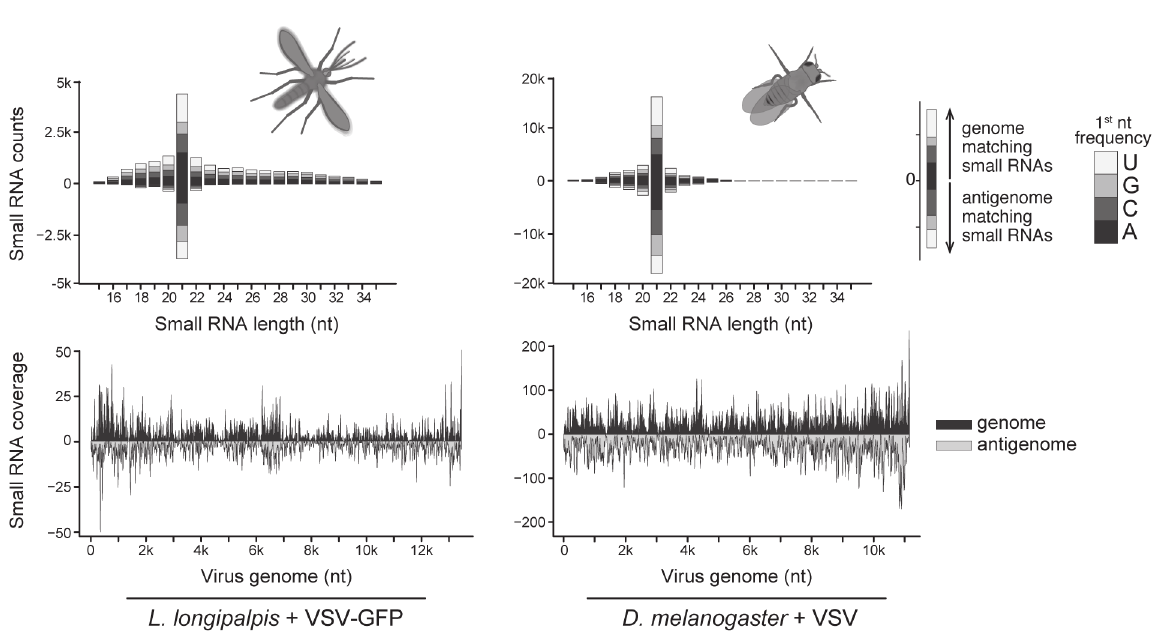
Figure 2 - Vesicular Stomatitis virus (VSV)-derived siRNAs in D. melanogaster and L. longipalpis . Activation of the siRNA pathway is a conserved response to virus infection in insects. Virus-derived siRNAs are mostly 21nt long small RNAs and show symmetrical base preference and polarity. siRNAs originate from both the viral genome and antigenome and can be detected along the entire extension of the virus sequence. Adapted from Ferreira et al. 2018 and Mueller et al.